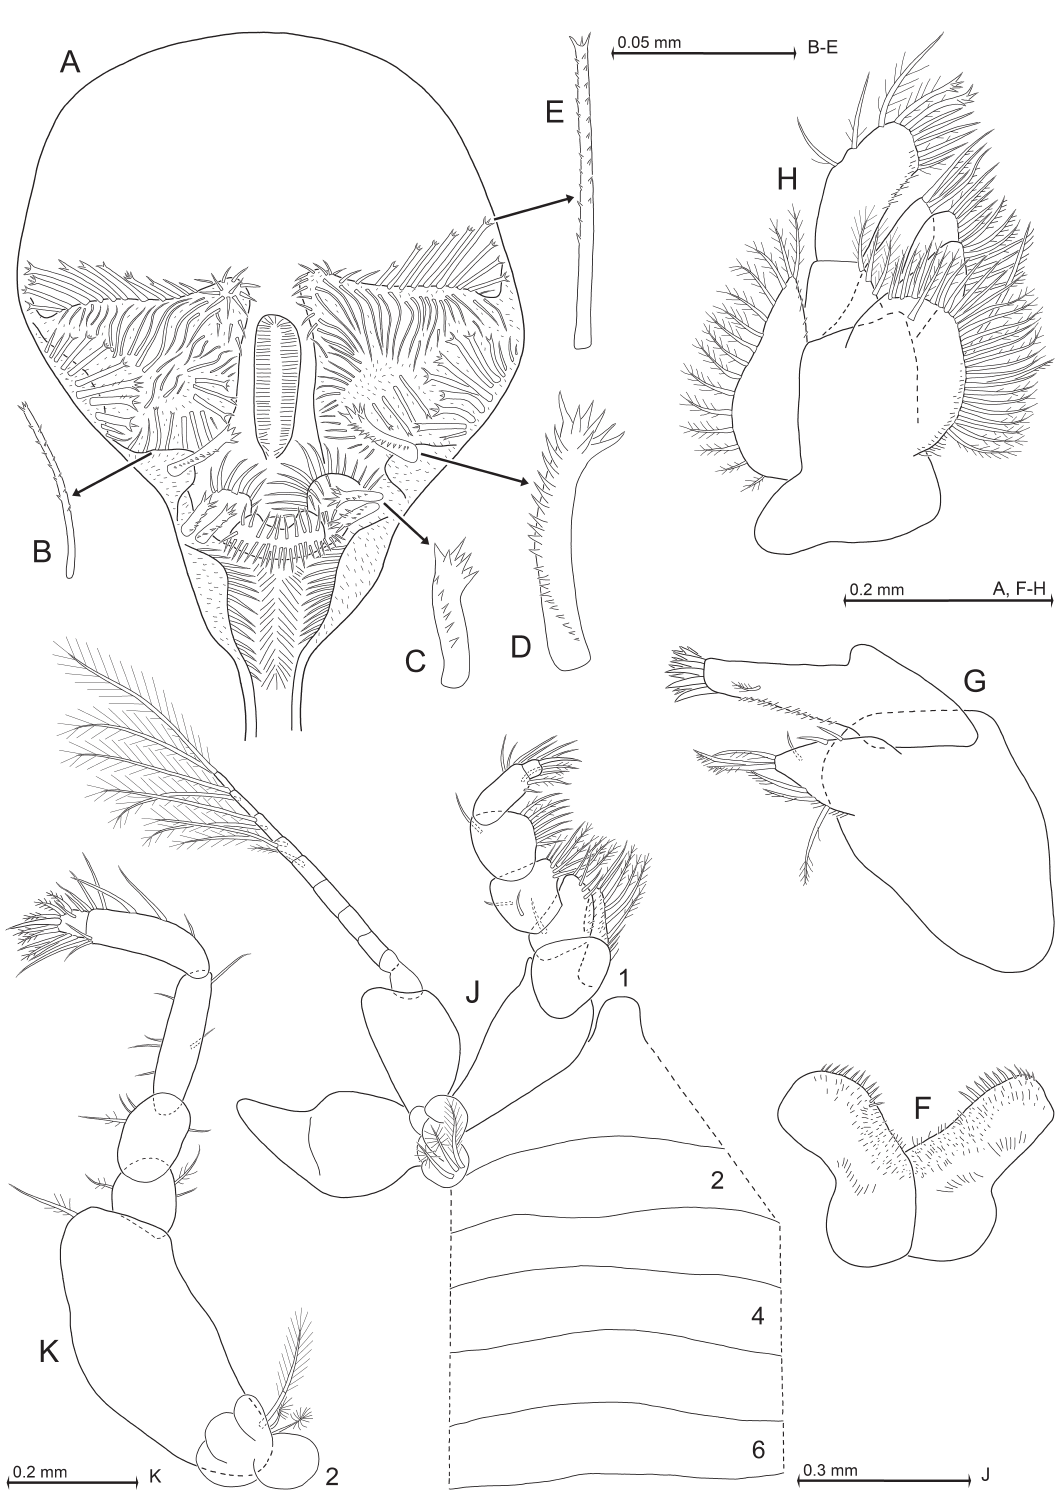
Fig. 11. Mysidium antillarum Wittmann sp. nov., from Curaçao, paratypes. A–E, G, J . ♀, 7.9 mm body length. F, K . ♂, 7.5 mm. H . ♀, 7.5 mm. A . Foregut; dorsal wall and some spines of superomedianum omitted. B–E . Details of panel (A) showing modified spines. F . Labium, caudal view. G . Maxillula, rostral view. H . Maxilla, rostral view. J . First thoracopod (caudal view) with sternites 1–6 (ventral view). K . Second thoracic sympod with endopod, rostral